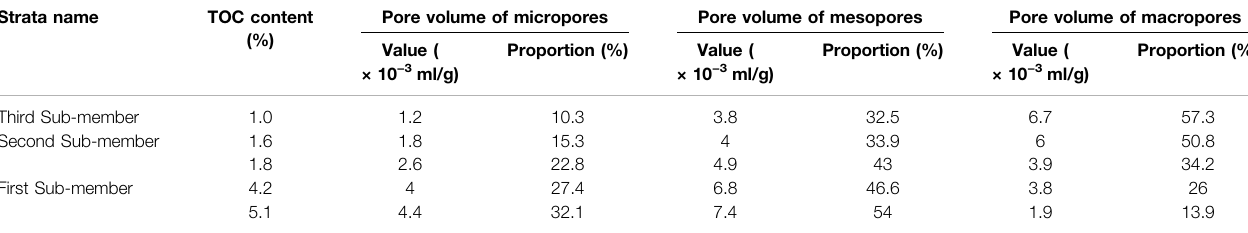
TABLE 1 | Pore volume and proportion of shaly micropores, mesopores and macropores in long 1 Fm. Strata